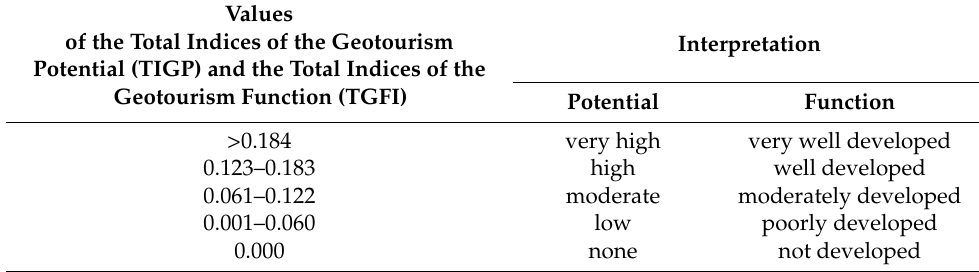
Table 5. Criteria for classification of geotourism potential and function. Values of the Total Indices of the Geotourism Potential (TIGP) and the Total Indices of